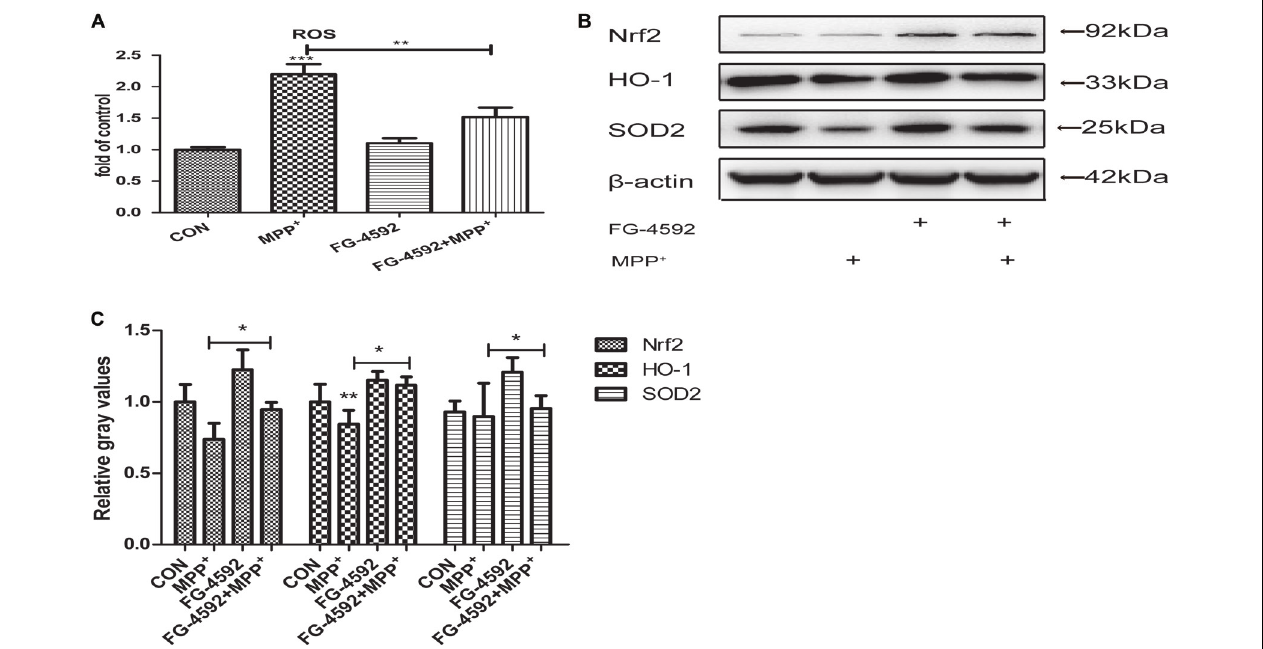
FIGURE 4 | FG-4592 prevented the MPP + induced generation of reactive oxygen species (ROS and increased the expression of antioxidant genes). SH-SY5Y cells were exposed to MPP + (3.5 mM) in the presence or absence of FG-4592 (50 µ M) for 24 h. The ROS level in different treated cell groups was showed in (A) . The protein level of Nrf2, HO-1 and SOD2 were determined by immunoblotting assay (B) . Western blotting analysis and quantification of the relative Nrf2, HO-1 and SOD2 protein abundance in the cells were showed in (C) . β -protein served as the control. Data were expressed as mean ± SD, ∗ P < 0.05, ∗∗ P < 0.01, ∗∗∗ P < 0.001 as compared to the control or MPP + ( n =